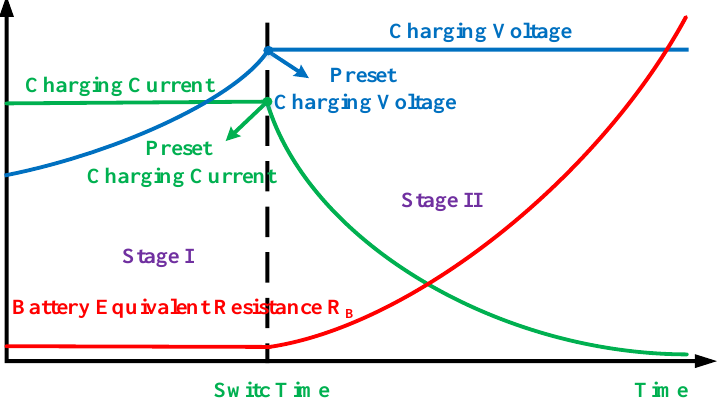
Figure 1. Typical charging profile of the Li-ion battery.